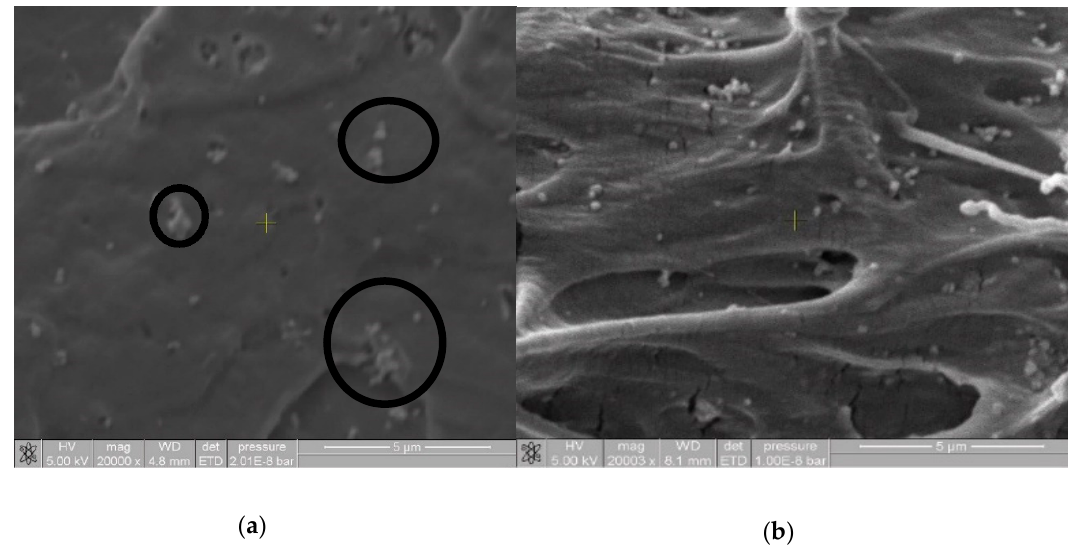
Figure 4. SEM images at 20,000 × of pigment dispersion (7 wt% TiO 2 ) in films prepared using the masterbatch MB10.PE2. USME-VF. ( a ) MB10.PE2.7% TiO 2 control; ( b ) MB10.PE2.7% TiO 2 .USW.